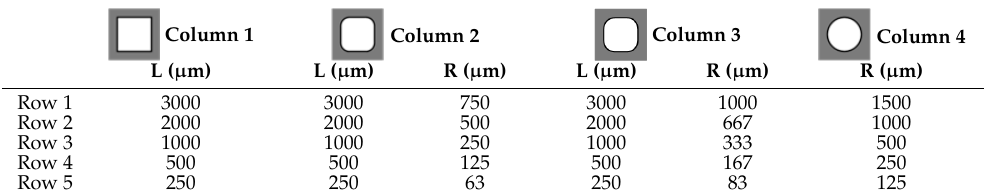
Figure 2. ( a ) Sample geometry design for laser micro-cutting and ( b ) row 1 with the design of shapes of each column. Table 3. Nominal dimensions of each sample for laser micro-cutting calibration.